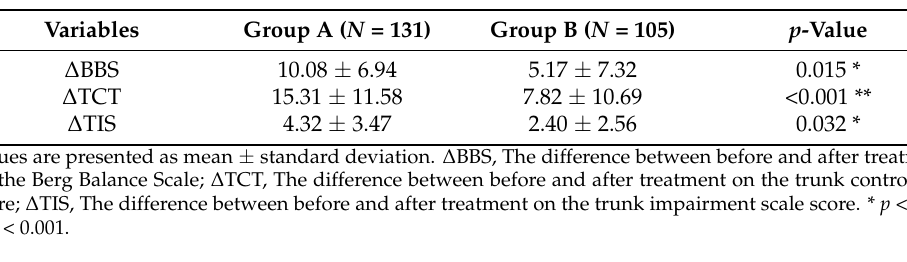
Table 4. Change of balance function before and after treatment between the two